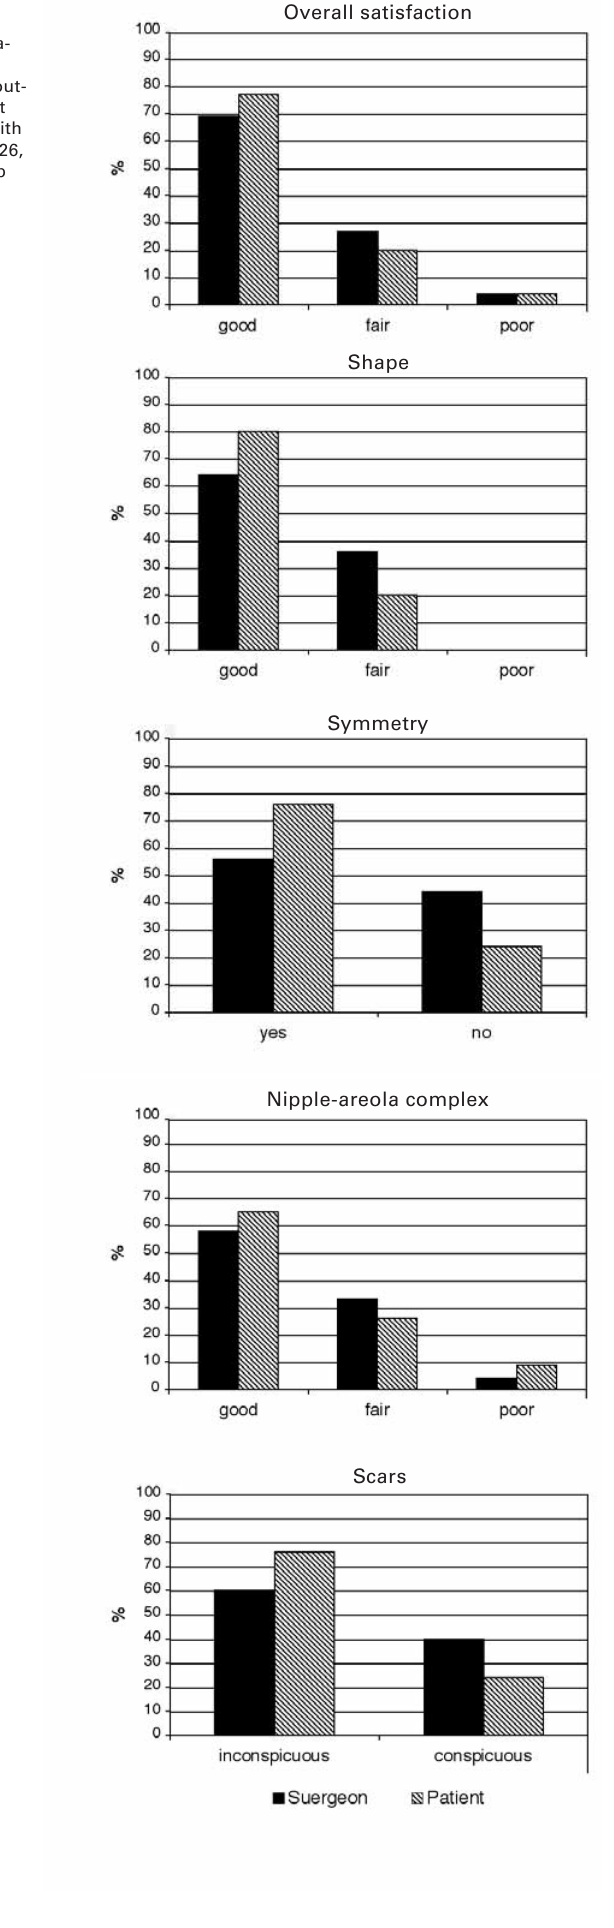
Figure 1 Surgeon’s and pa- tient’s evaluation of the aesthetic out- come after breast reconstruction with TRAM flaps (n = 26, median follow-up 27.5